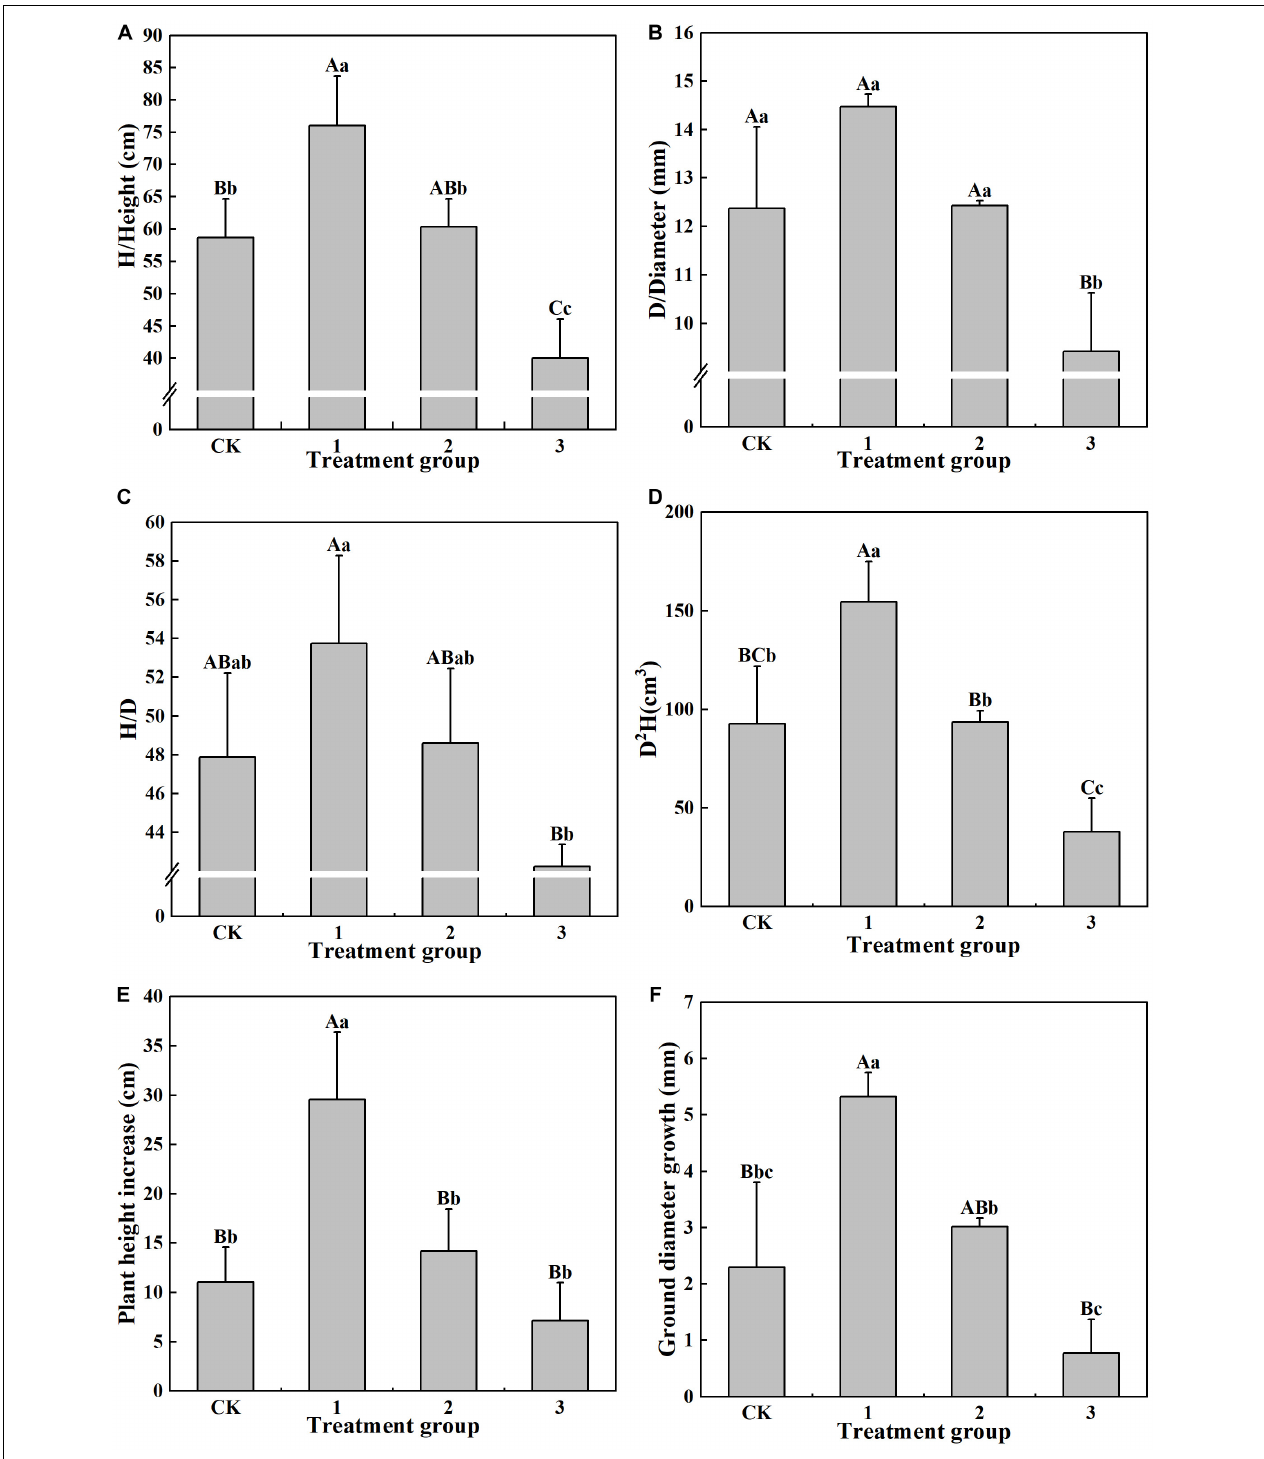
FIGURE 1 | The effect of different treatments on the growth index of Horsfieldia hainanmensis The uppercase letters in the figure indicate P < 0.01, and the lowercase letters indicate P < 0.05, which respective indicate extremely significant and significant differences (A–D) , respectively, represent the influence of different light transmittance on the plant height, ground diameter, height to diameter ratio, and biomass of Horsfieldia hainanmensis (E,F) represent the influence of different light transmittance on the growth of plant height and ground diameter of Horsfieldia hainanmensis .